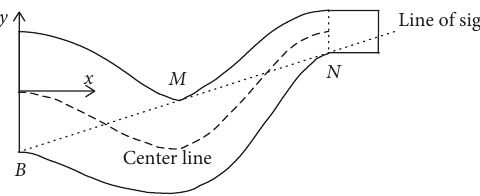
Figure 2: The geometric condition of complete shielding.